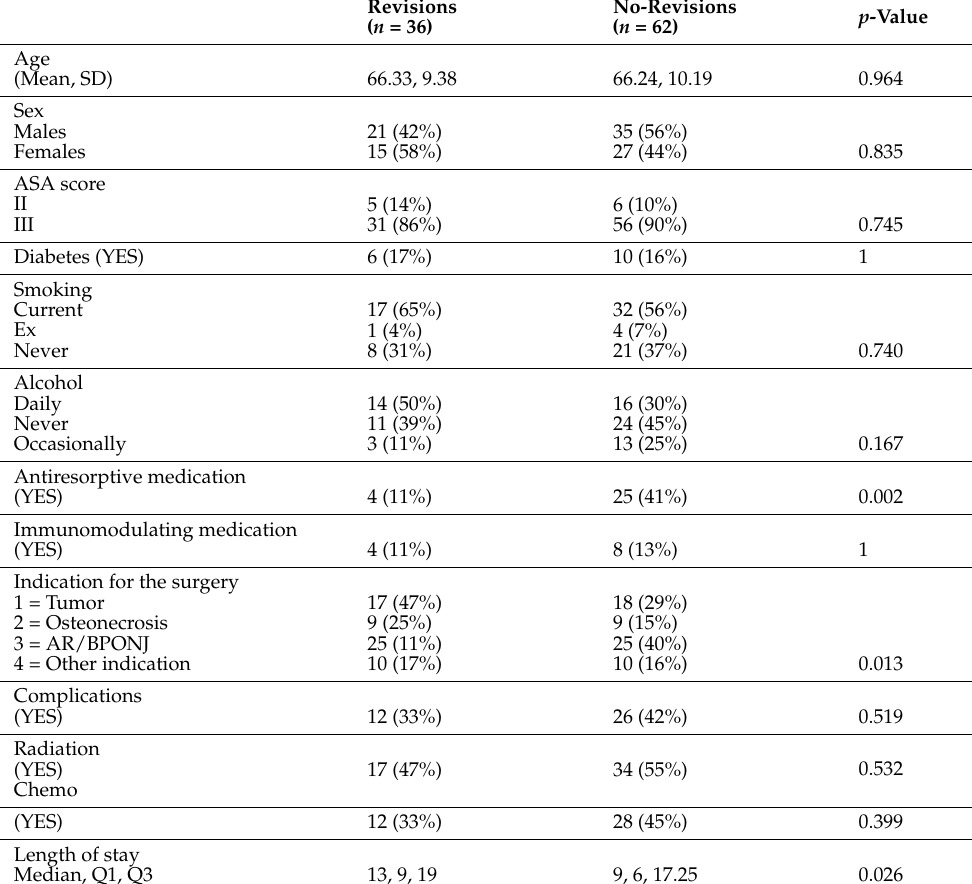
Table 3. Baseline demographic features comparison for revisions/no-revisions